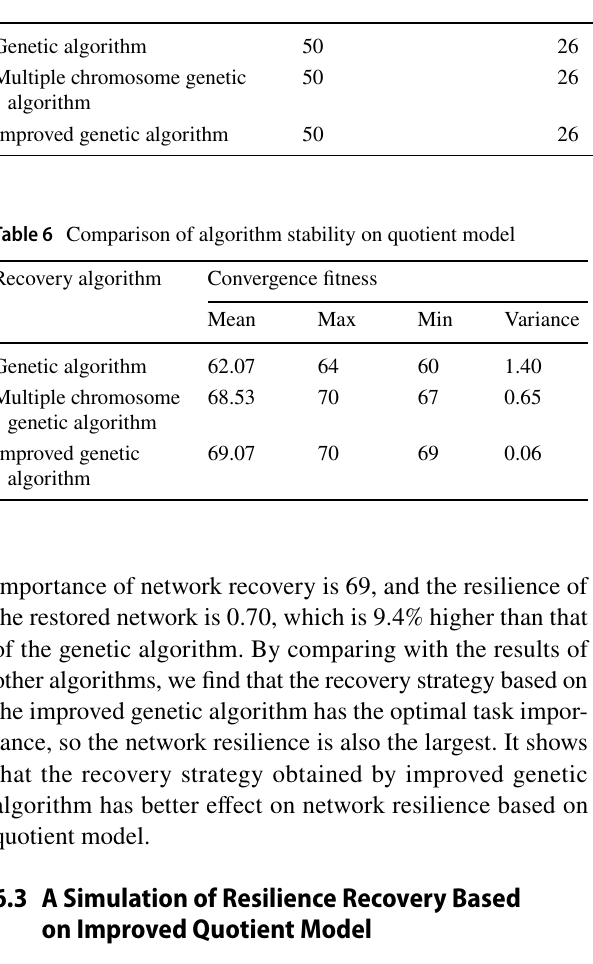
Table 5 Comparison of recovery algorithm repair results Recovery algorithm